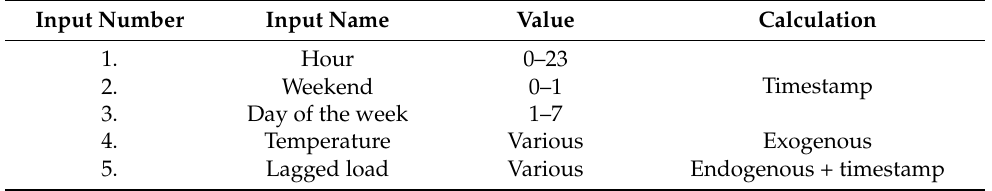
Table 2. Selected input